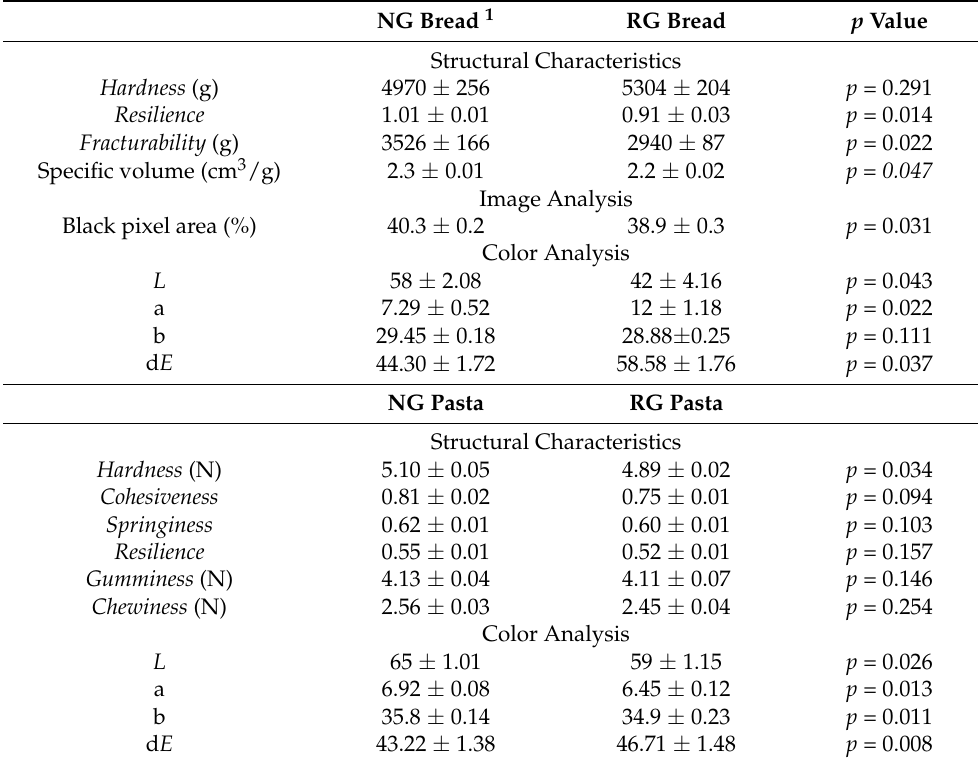
Table 2. Structural and image and color characteristics of bread and pasta made with normal-(NG) and reduced-(RG) gluten content flours. RG wheat flour was fermented with fungal proteases and selected lactobacilli at 30 ◦ C for 8